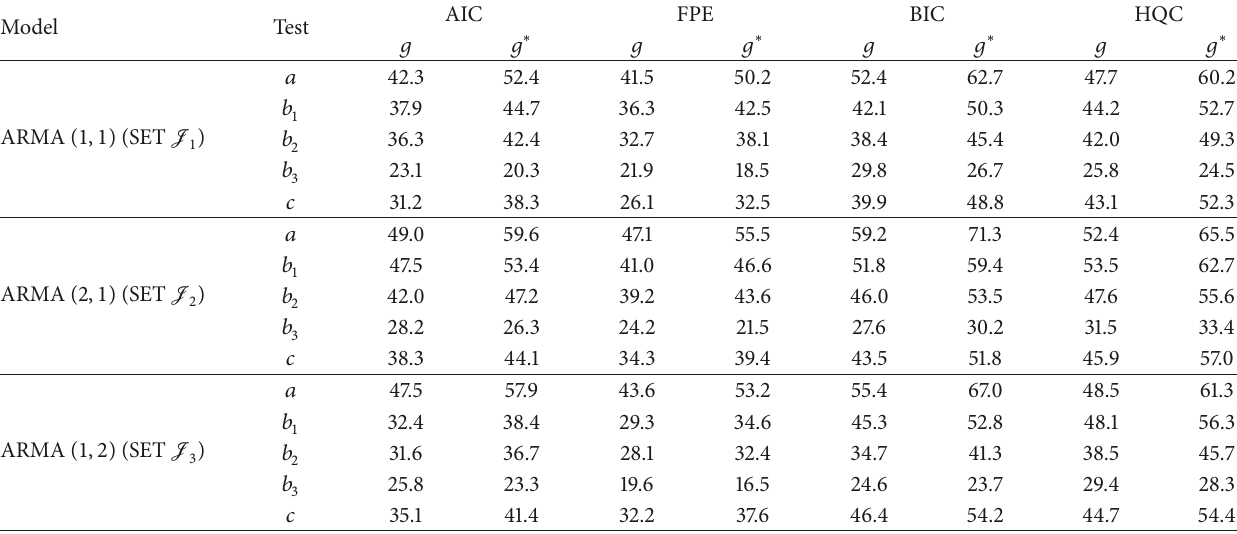
Table 2: Frequency of selection of the true model in the nonbootstrap ( 𝑛𝑏 ) and bootstrap ( 𝑏 ) world for 𝑇 = 100 . Model